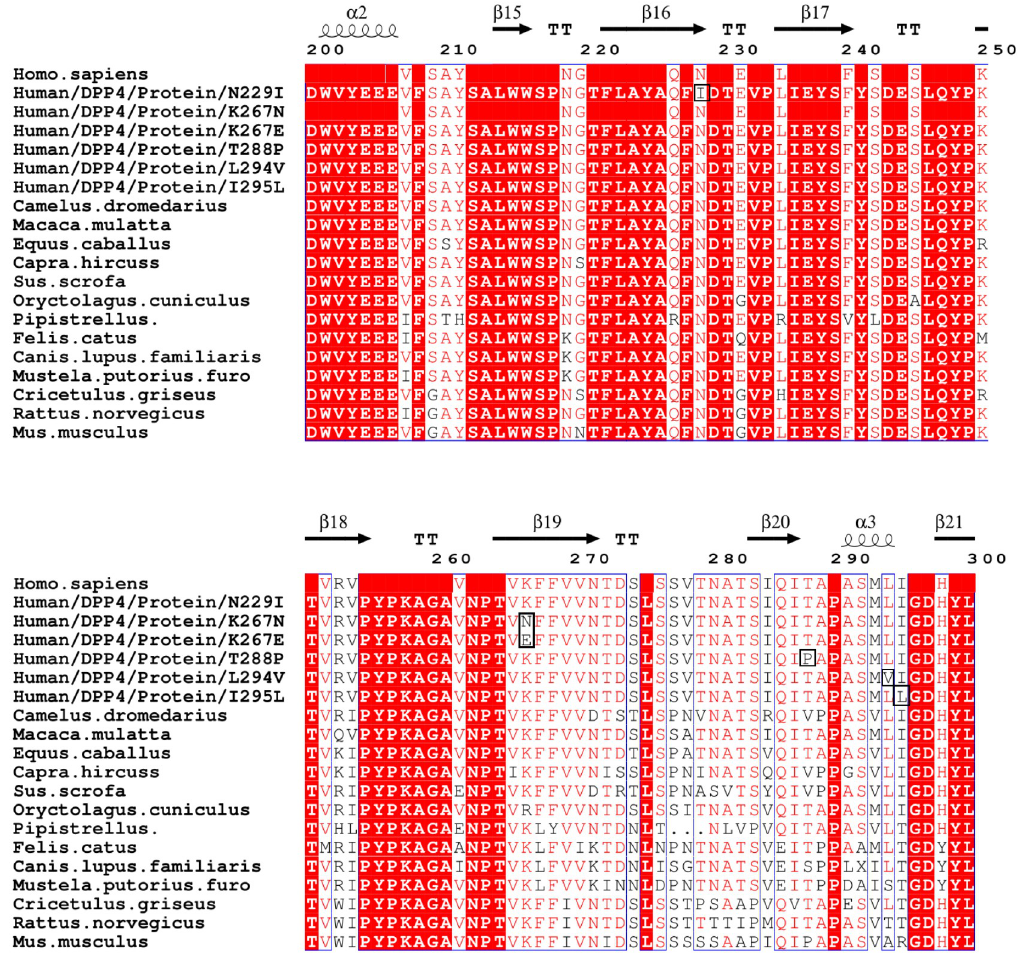
Fig 1. Alignment of human and animal DPP4 protein sequences by Clustal W. Identical amino acid residues in different species are highlighted with the same residue colour. Mutations identified in this study are highlighted in black.